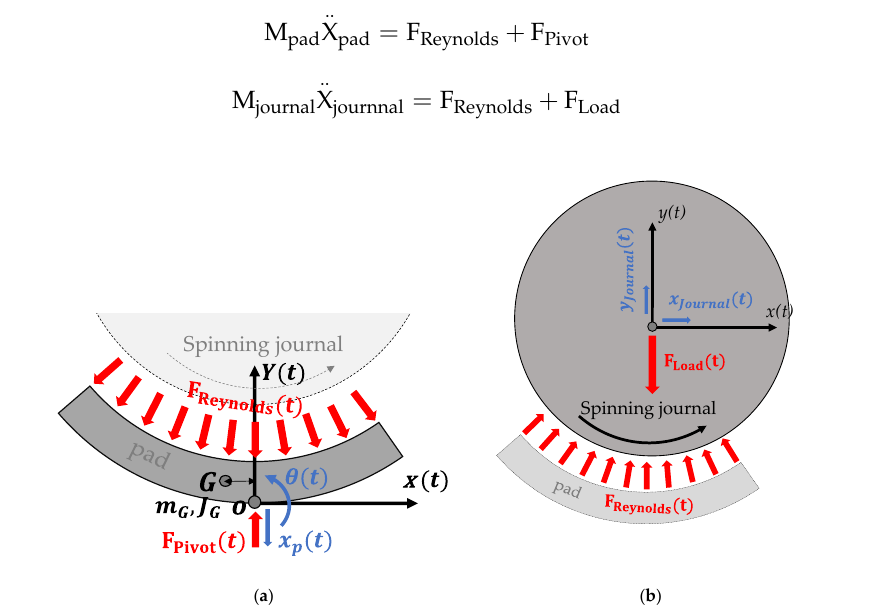
Figure 5. Tilting pad journal bearing dynamic model: ( a ) pad dynamic model; ( b ) journal dynamic model.